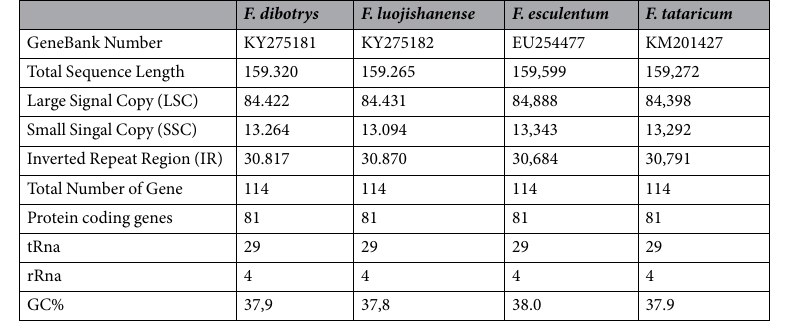
Table 2. Comparison of the complete chloroplast genome contents of four Fagopyrum